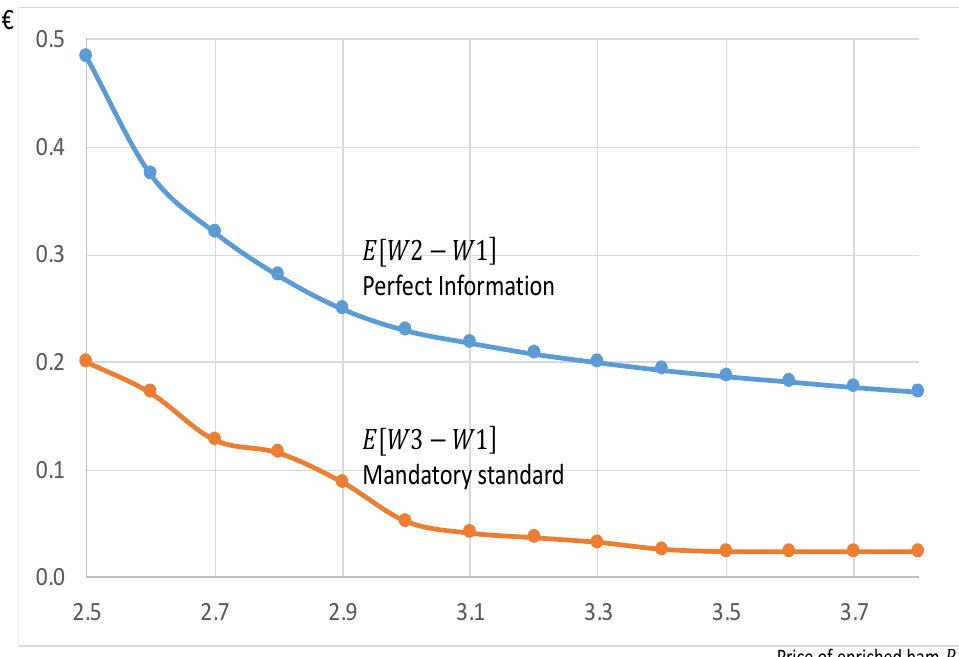
Figure 5. Average variations of consumers’ surpluses for one packet of enriched ham with a mandatory standard.